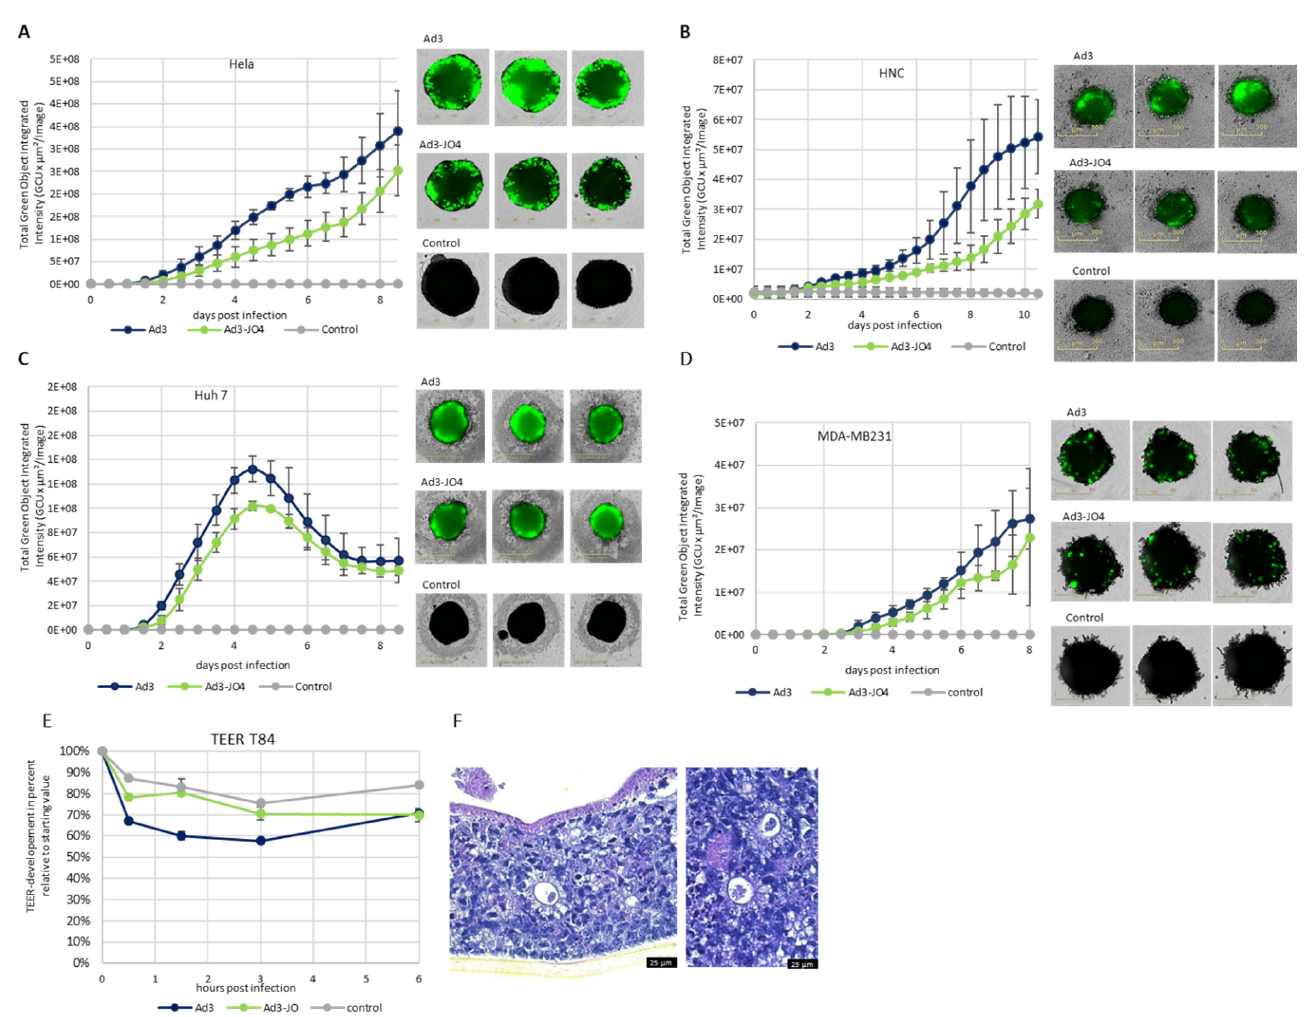
Figure 4. Performance of JO4-containing vectors in 3D cell culture model. ( A – D ) Spheroids of human carcinoma cell lines Hela (cervix), HNC (head and neck), Huh 7 (liver) and MDA-MB-231 (breast). Approximately 1000 cells/well were seeded. After four days of culture, dense spheroids had formed and were then infected with 500,000 viral particles/well of Ad3 and Ad3–JO4. ( Left ): development of GFP expression in infected spheroids. Values calculated from green fluorescence images taken every 12 h postinfection. ( Right ): Overlay of brightfield and green fluorescence images 6 days postinfection. ( E ) Trans-epithelial electrical resistance (TEER) measurement of T84-transwell culture after Ad3 and Ad3-JO4 infection. 400 vp/c of both viruses was applied on the apical side (inner chamber). TEER was measured before infection and at 0.5, 1.5, 3 and 6 h postinfection. Values are normalized as percent of TEER (Ohm/cm 2 ) relative to starting value, which is defined as 100%. ( F ) Histological analysis of the T84-transwell cultures. HE dye of an apical–basal paraffin cut of T84 cells cultivated in a transwell. There are signs of colon epithelial organotypic differentiation: several crypts that are partially formed by light and mucus-containing goblet cells. For ( E , F ), T84 cells were cultured under standard conditions (medium in top and bottom compartments) for 4 days until reaching confluency, and then they were kept under semi-wet interface with a differentiation medium for 25 days until persistent TEER was achieved. ( A , B ) represent the means of three independent experiments. ( C – E ) represent one of at least two independent experiments. All experiments were conducted in technical triplicates. Error bars represent standard deviations.